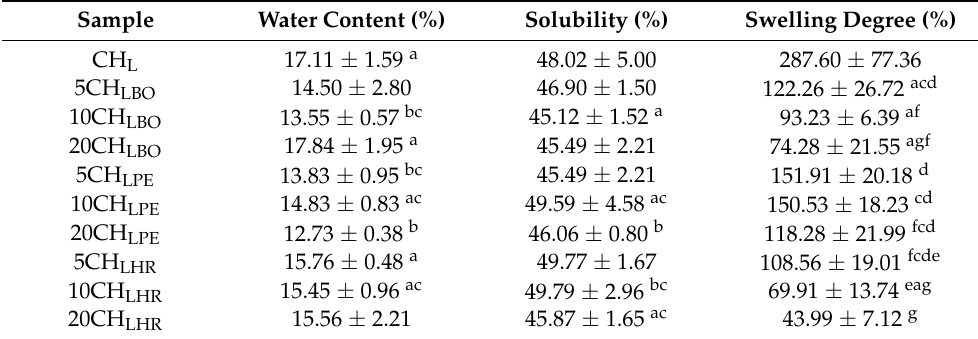
Table 6. Water content, solubility and swelling degree of